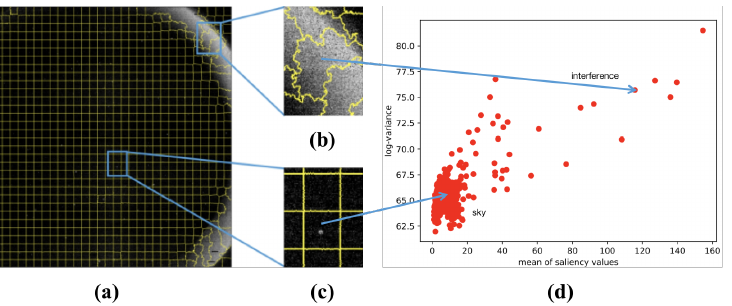
Figure 9. Feature extraction: ( a ) the result of optimized SLIC segmentation; ( b ) details of large-area interference region; ( c ) details of region with suspected star spot; and ( d ) distribution of feature vector extracting from